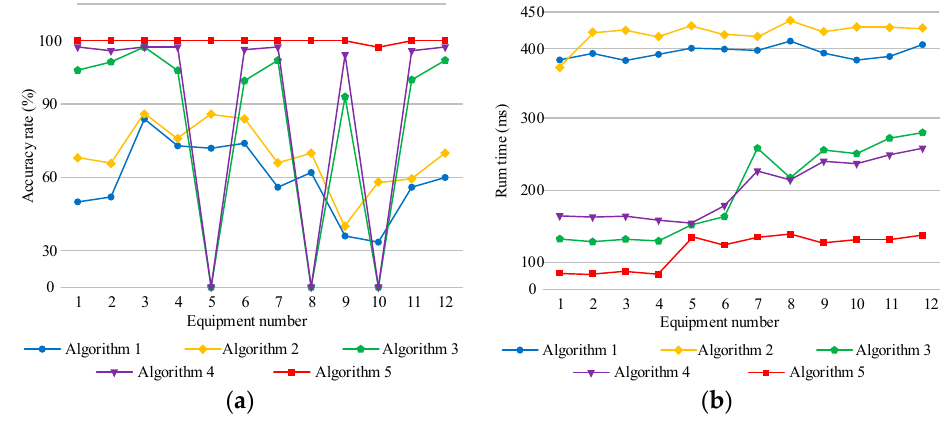
Figure 10. The test results of IEEE 69-node distribution network. ( a ) Accuracy comparison; ( b ) comparison of computational e ffi ciency.